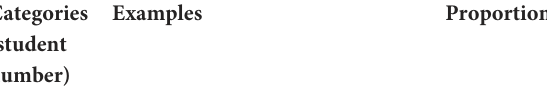
TABLE 3 Classification of students’ learning